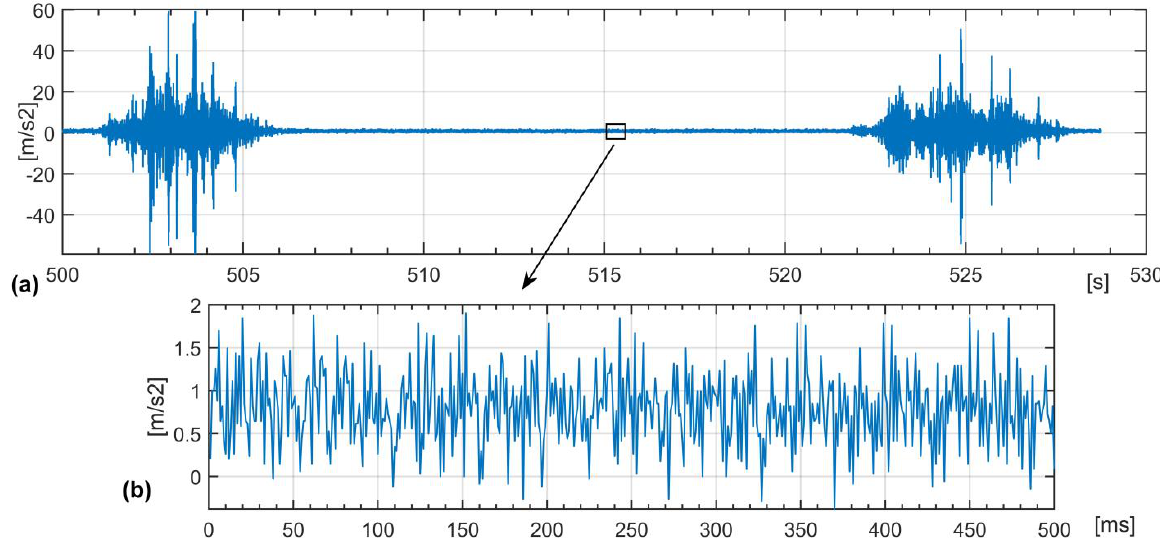
Figure 1. Sensor data ( a ) wheel impacts at rail joints; ( b ) rolling wheels data.